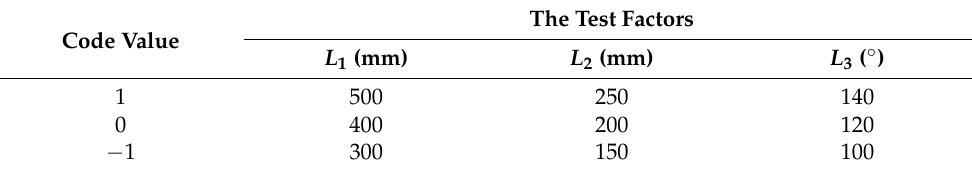
Table 1. Factor level coding table. Code